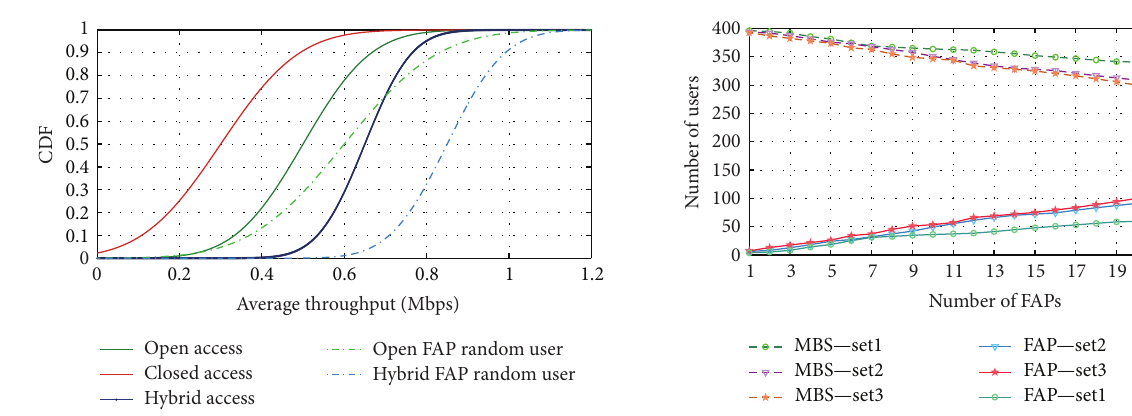
Figure 5: Average throughput of random users for different access mechanisms.